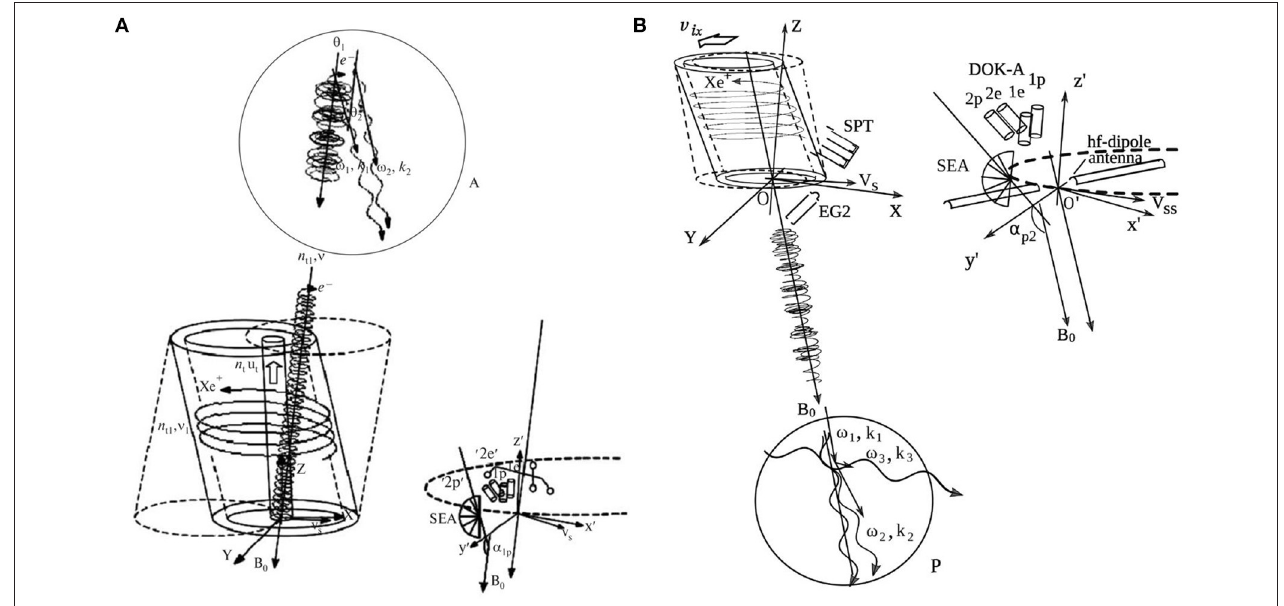
FIGURE 10 | (A) Electron beam injection ( e − , modulation mode S250) directed through the hollow beam of xenon ions (Xe + , no modulation F0) with the beams density and velocity n be , v , and n bi , v i , respectively. Release of the electron flow with the density and stream velocity n e , u e , for a compensation of the ion beam charge at the output of UPM is shown by the up arrow. Here, B 0 and v s are the directions of the quasi-steady magnetic field and the satellite velocity in the XYZ coordinate system, Z-axis points away from the Earth. Circle A—region of whistler-mode wave ( ω , k ) generation by the electron beam e − at angle θ to the magnetic field. (“1e, 1,” “2e, 2p”) are two pairs of the DOK–A–S energetic particle sensors, SEA is the six-sector soft electron detector of the MPS/PPS spectrometer, α 1 p is the pitch-angle of the first sector registration in the x’, y’, z’ MAGION–3 coordinate system. Injection configuration for orbits 201, 202. (Reprinted from Baranets et al., 2014 ). (B) Electron beam injection ( e − , modulation mode F40K) directed opposite to the hollow beam of xenon ions (Xe + ), disposition sketch of the electron gun (EG2) and stationary plasma truster (SPT) are shown in the IK–25 satellite coordinate system OXYZ. Sensors for the soft and fast charged particles belonging to the spectrometers MPS/PPS (SEA) and DOK–A–S (“1e, 1p,” “2e, 2p”), respectively, and hf-dipole antenna (HF-receiver PRS–S) are shown in the subsatellite system Ox’y’z’, where α p 2 is a pitch-angle of soft electrons detected through the 2nd sector of the SEA sensor aperture; v ix as well as V s and V ss are the inertia Xe-ion velocity shear and velocities of the satellite and subsatellite, respectively. Region P is a symbolic sketch of three-wave interaction. The distance OO’ was about ≃ 110 km for orbit 190. (Reprinted from Baranets et al., 2017, with permission from